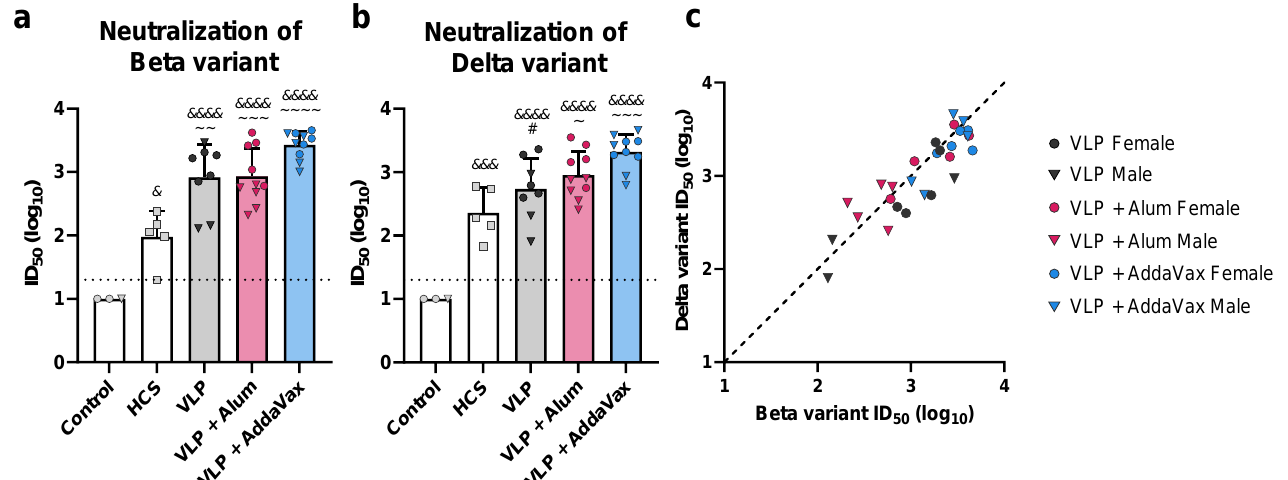
Figure 3. Functional antibody response to the monovalent VLP vaccine. Neutralizing antibody titers in sera collected from VLP-immunized mice, sera collected from mice prior to immunization (Control), and human convalescent sera (HCS) were measured using a Spike-pseudotyped lentivirus neutralization assay. ( a ) Beta variant Spike-pseudotyped lentivirus neutralization. ( b ) Delta variant Spike-pseudotyped lentivirus neutralization. Neutralizing antibody titers are presented as the serum dilution at which half of the pseudovirus was neutralized as compared to serum-negative controls (ID 50 ). ID 50 values for individual animals are presented as either circles ( ● ) for females or triangles ( ▼ ) for males. Dotted line indicates lower limit of detection. ( c ) Correlation of neutralizing antibody titers against the Beta and Delta variants. Dashed black line indicates a slope of 1, included to visualize the skew of the data. In ( a ) and ( b ), data are mean + SD. Results were analyzed by one-way ANOVA with Tukey’s multiple comparisons test, with P < 0.05 considered significant. Ampersands (&) indicate comparisons with Control, tildes (~) indicate comparisons with HCS, and pound signs (#) indicate comparisons with the VLP + AddaVax group. * P < 0.05, ** P < 0.01, *** P < 0.001, **** P < 0.0001 (The asterisks in the figure legend represent all statistical comparisons, regardless of symbol used. #, &, and ~ in the figure are represented by asterisks in the figure legend, to significantly shorten the length of the legend).